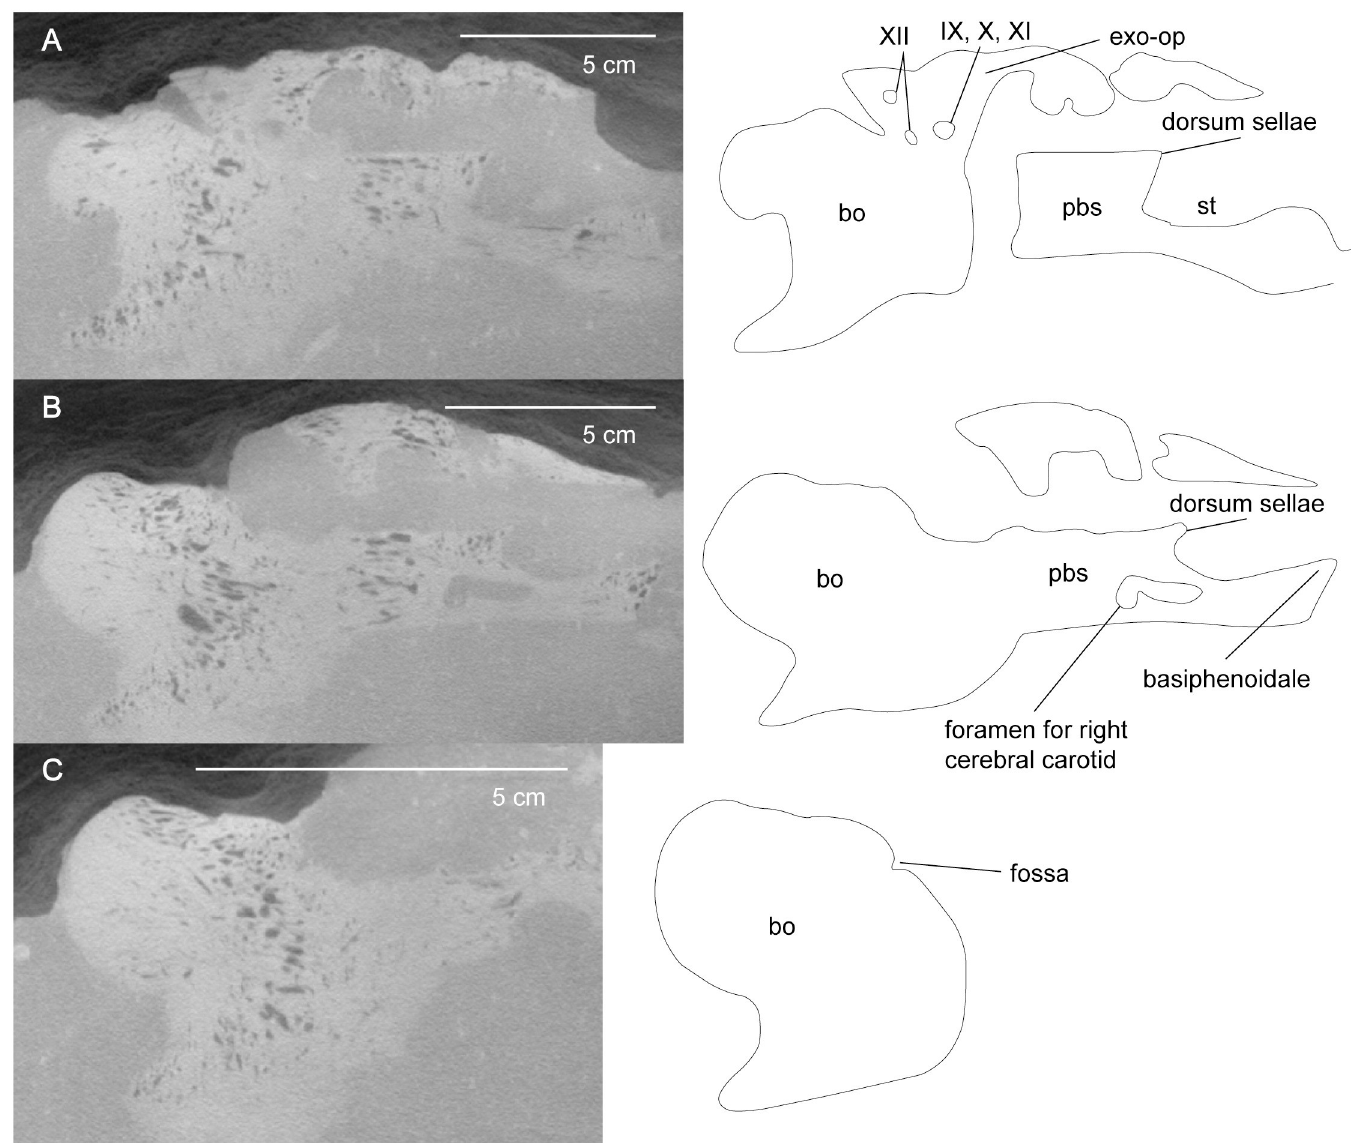
Fig 11. Parasagittal section of braincase from Cardiocorax mukulu (MGUAN PA278). A. Parasagittal section of braincase exposing cranial foramina (IX, X, XI, XII), and dorsum sellae. B. The opening of the right cerebral carotid. C. Fossa for plexus basilaris exposed on basioccipital.